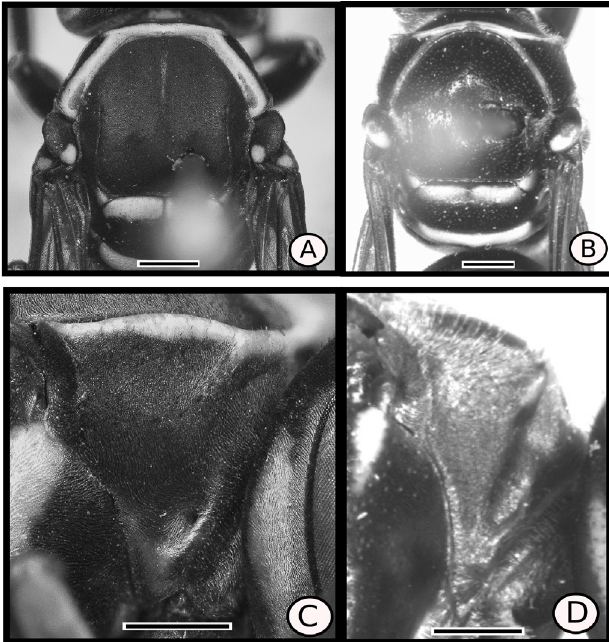
Fig 4 . A and C: scutum in dorsal view and pronotum in lateral view of Chartergellus trinitatis, respectively; B and D: scutum in dorsal view and pronotum in lateral view of Chartergellus afoveatus, respectively . Scale bar = 1.0